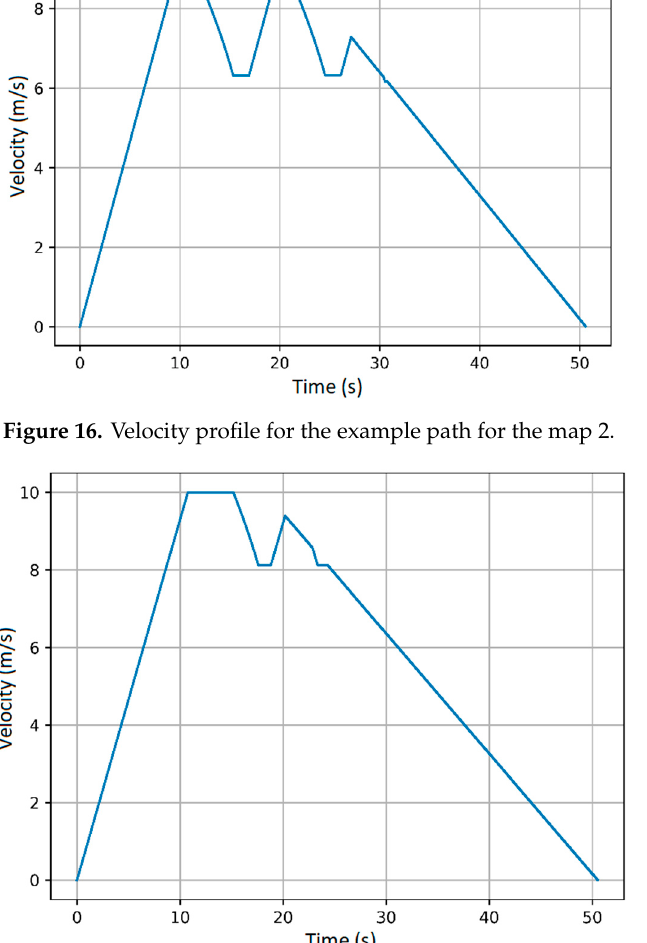
Figure 17. Velocity profile for the example path for the map 3.